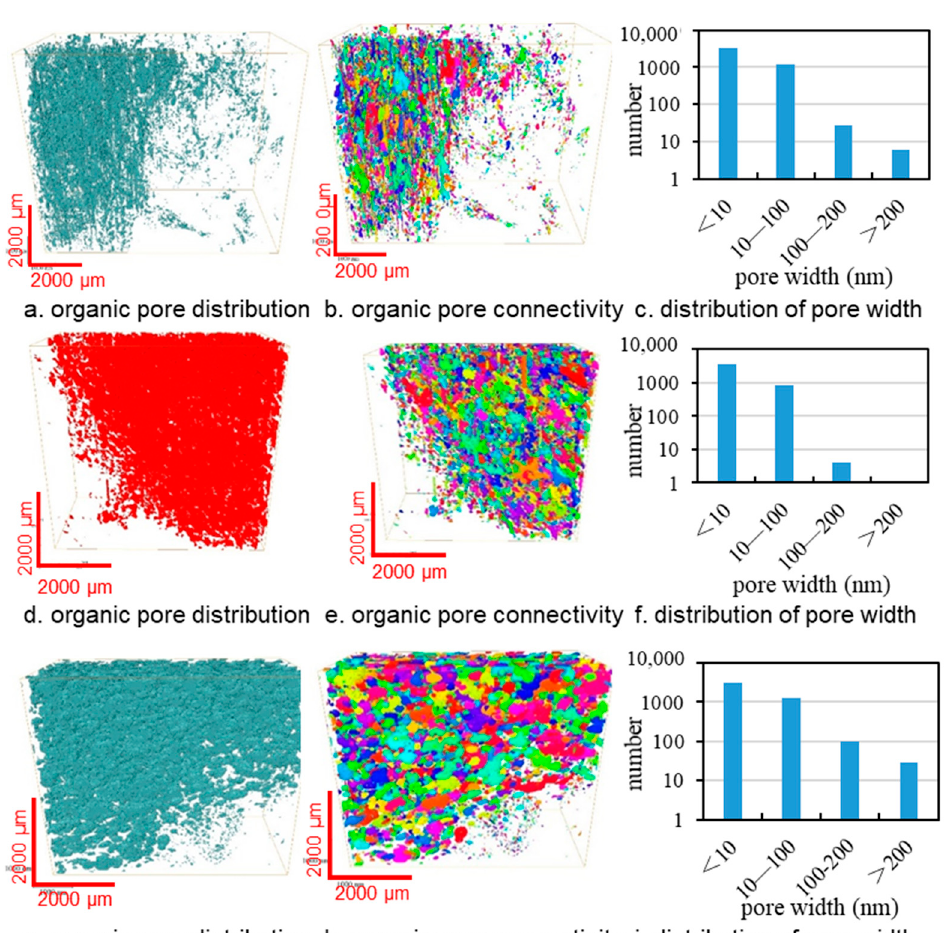
Figure 10. Three-dimensional focused ion beam (3D-FIB) microphotographs and statistical data of Wufeng-Longmaxi Formation in Sichuan Basin. ( a – c ): Wufeng Formation; ( d – f ): lower member of Longmaxi Formation; ( g – i ): upper member of the Longmaxi Formation.